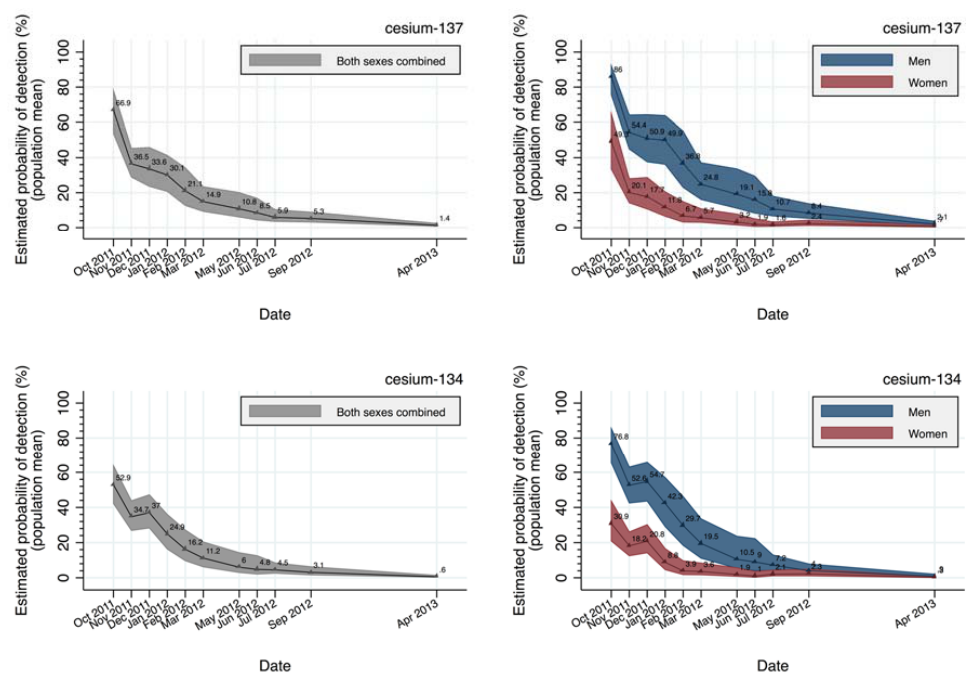
Figure 4. A population mean of modeled estimates of the probability of Cs detection and the corresponding 95% confidence band in both sexes combined ( left ) and in men and women ( right ) for Cs-137 ( upper ) and Cs-134 ( lower ). The confidence band was demarcated by the population mean of the upper and lower limit of the confidence intervals of modeled probability of Cs detection. The point at April 2013 covers the time period until March 2015.